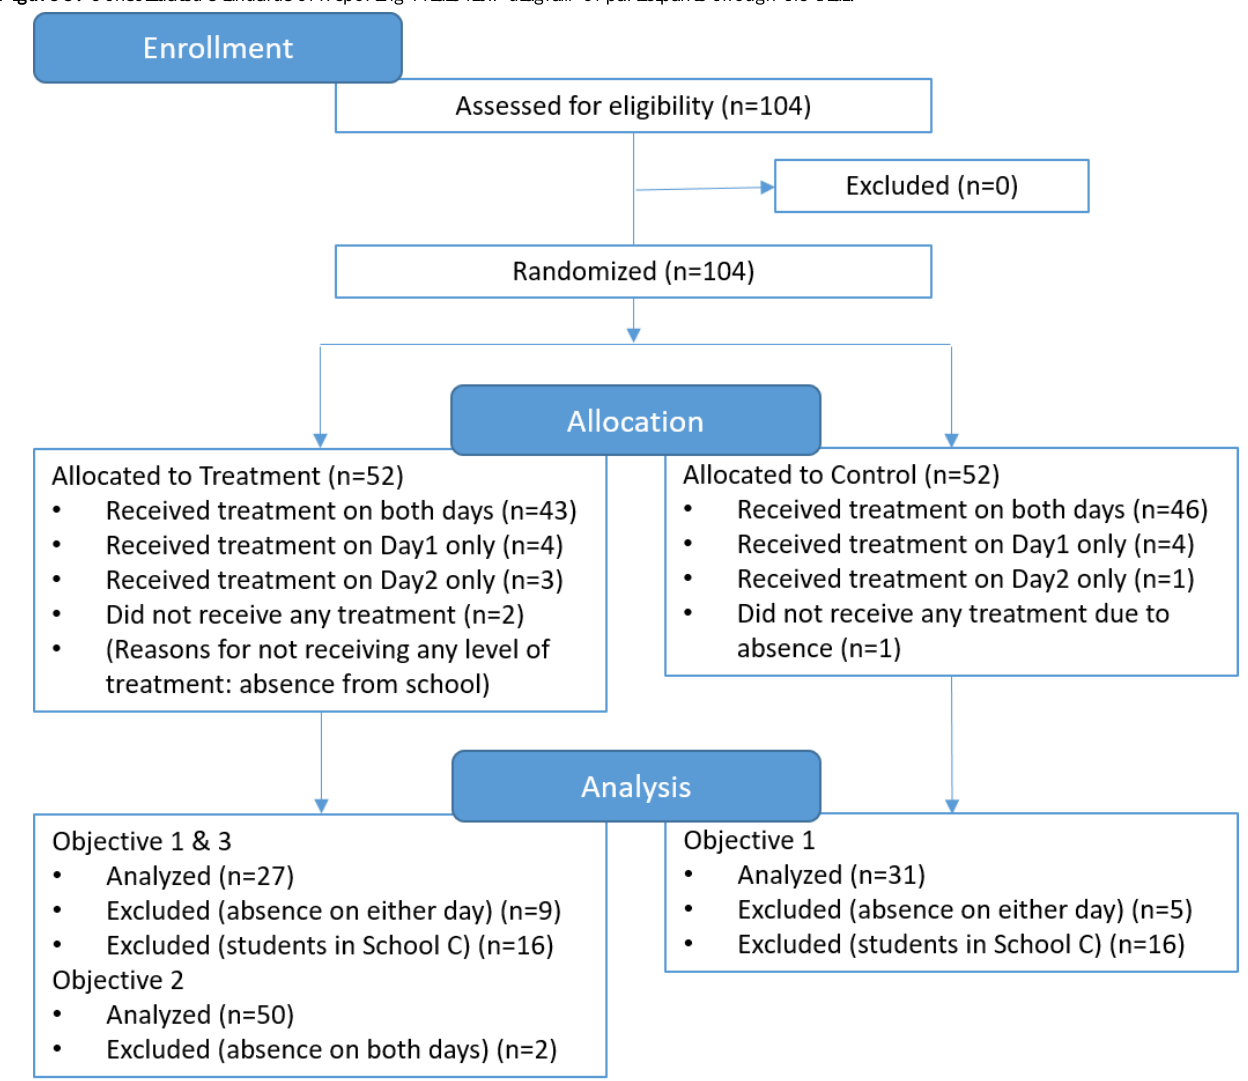
Figure 3. Consolidated Standards of Reporting Trials flow diagram of participants through the